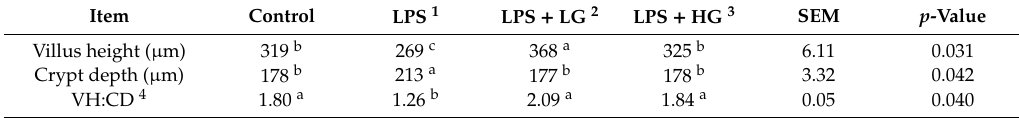
Table 7. Jejunal morphology of piglets fed di ff erent molecular weight β -glucan.